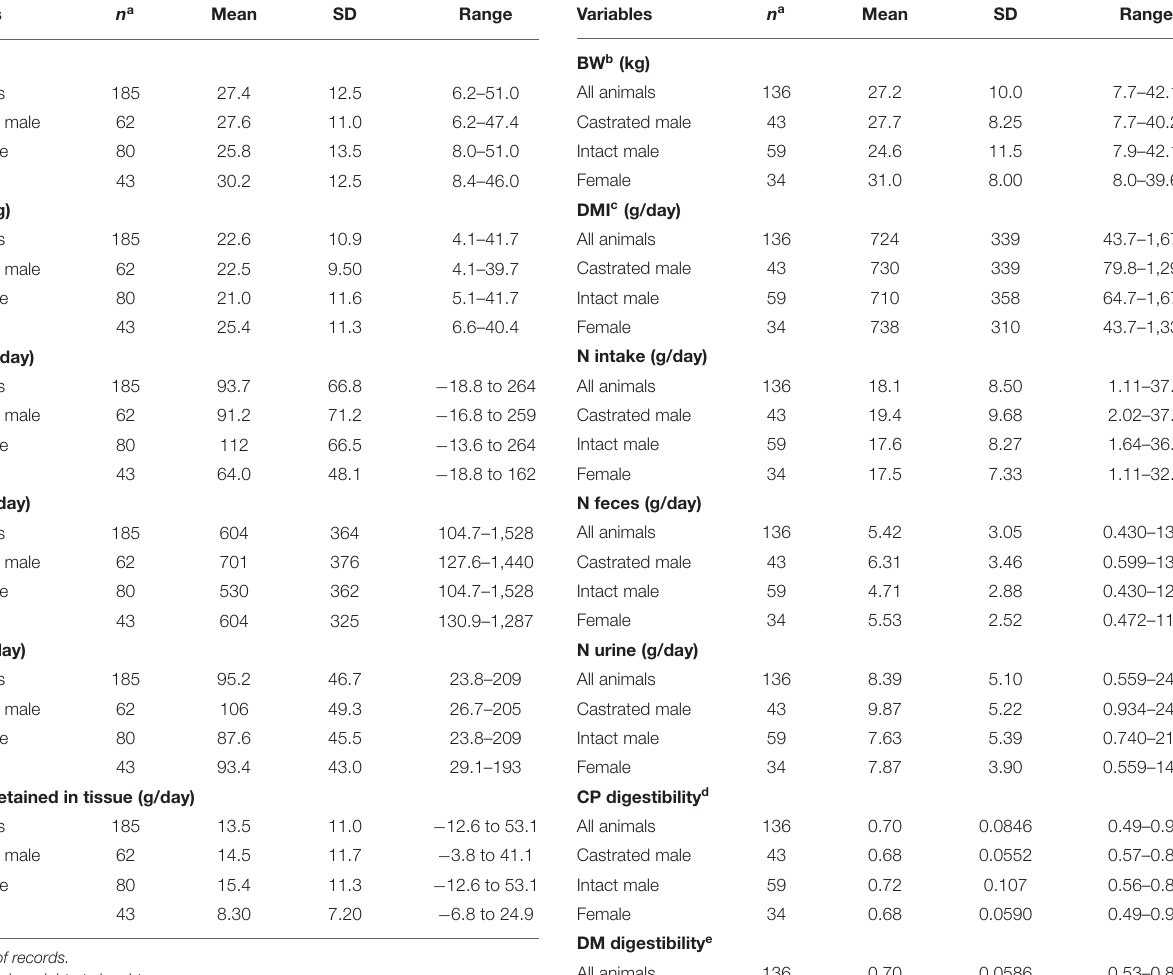
TABLE 1 | Summary of descriptive statistics of body composition and intake of Saanen goats used in the comparative slaughter technique.